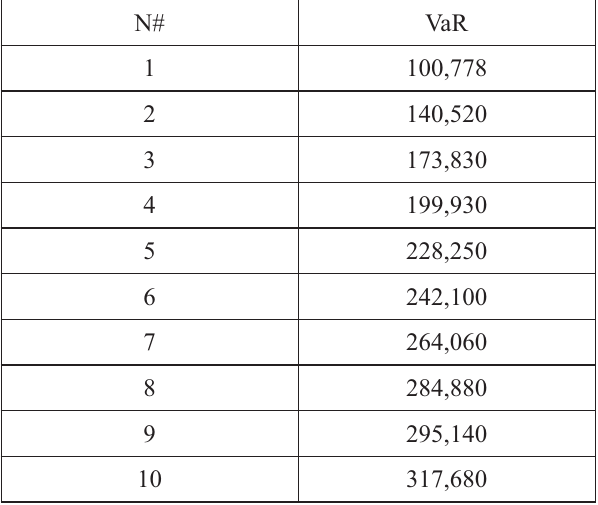
Table 2. VaR values with different notions of “t” variable